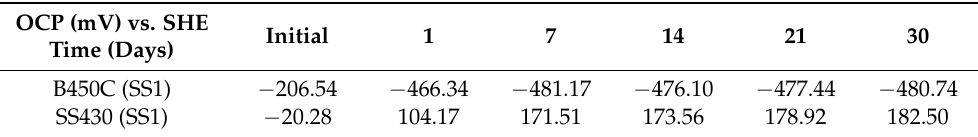
Table 6. Change in time of the free corrosion potential values (OCP) during immersion of SS 430 and carbon steel B450C in SS1 cement extract solution up to 30 days. OCP (mV) vs.